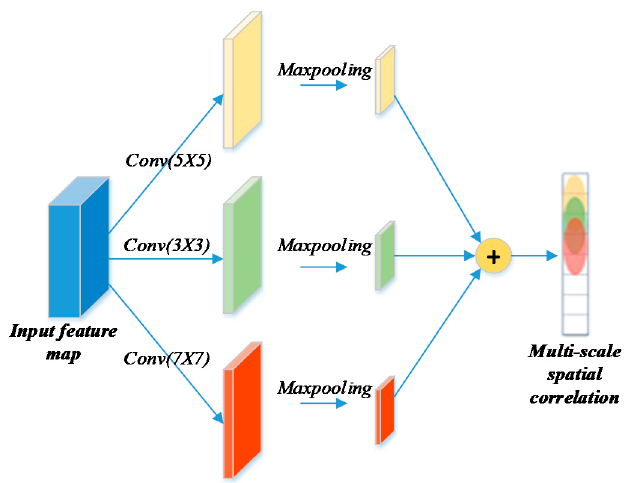
Figure 5. The proposed multi-scale convolutional strategy possesses higher adaptability for a diversified reception field.